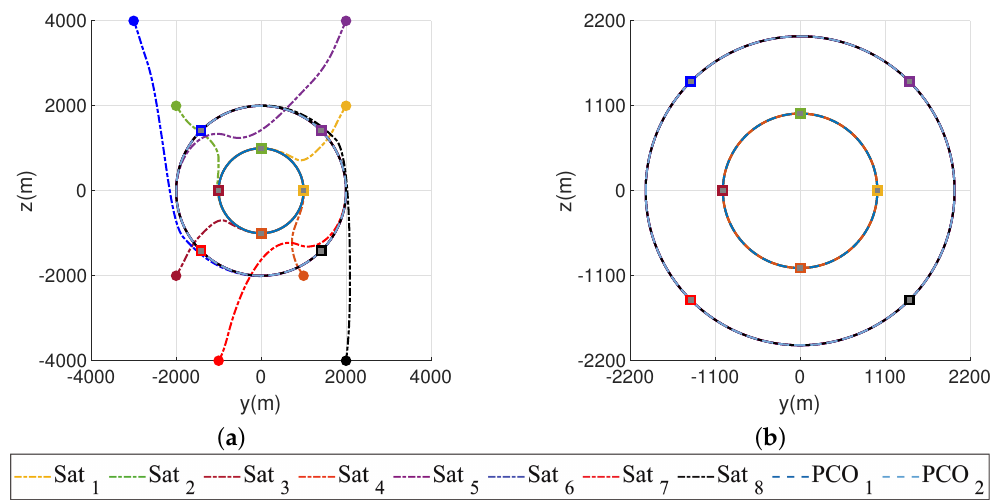
Figure 11. PB law. Plots of trajectories: ( a ) on plane YZ; ( b ) on plane YZ after orbiting.